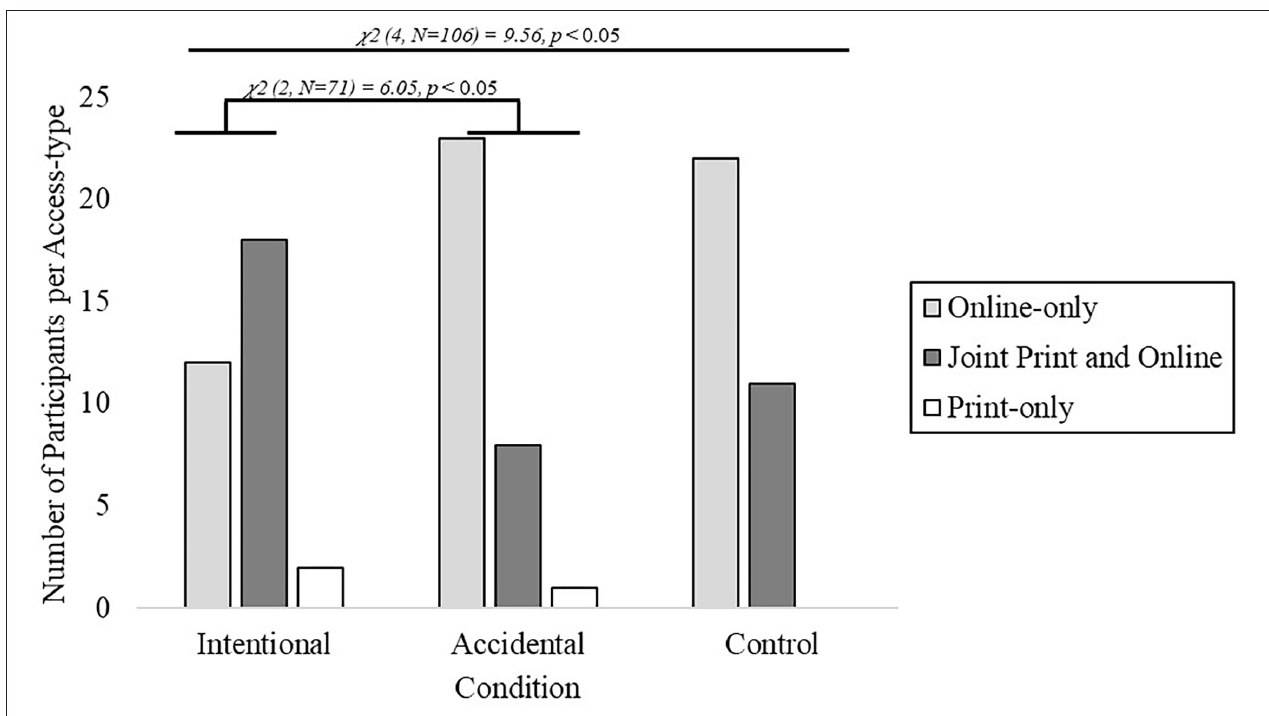
FIGURE 3 | Forced choice results obtained from Experiment 2. Participants were more likely to choose the print and online subscription option and less likely to choose the online subscription option in the Intentional condition compared to Accidental and Control conditions, χ 2 (4, n = 97) = 10.20, p =